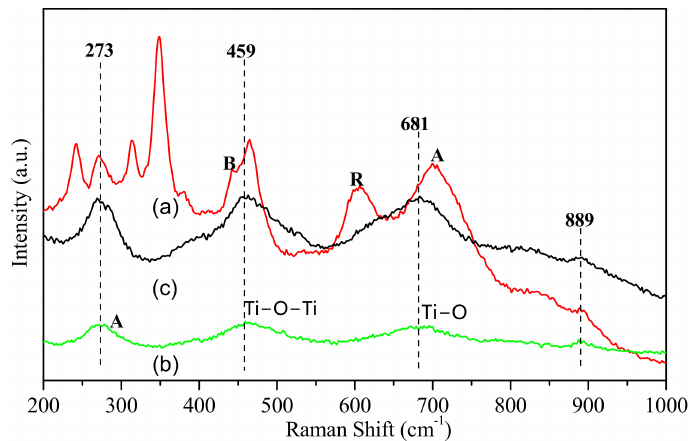
Figure 6. The Raman spectra of NT-purchased ( a ), NT-P25 ( b ), and NT-TBOT ( c ), after treatment with hydrogen